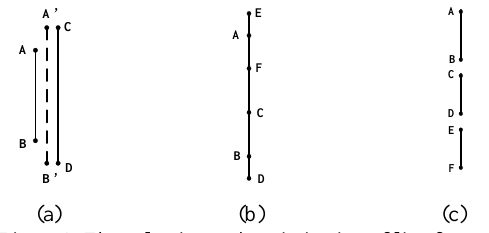
Figure 3. The selection and optimization of line features 3. THE SIMILARITY MEASURE UNDER THE CONSTRAINT OF THE